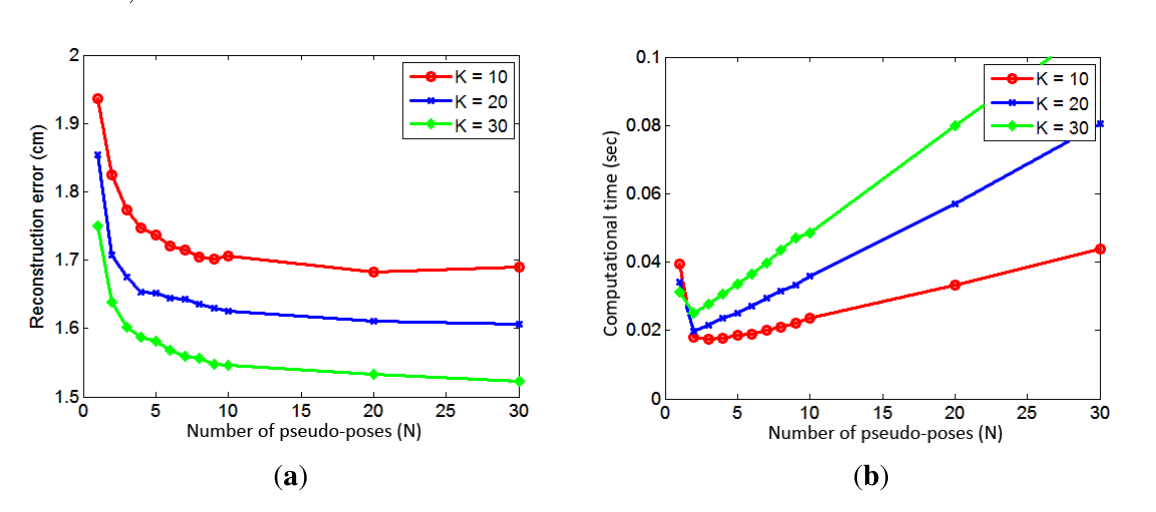
Figure 9. ( a ) Reconstruction errors at different numbers of pseudo poses for K = 10 , K = 20 and K = 30 . ( b ) Computation times at different numbers of pseudo poses for K = 10 , K = 20 and K = 30 .